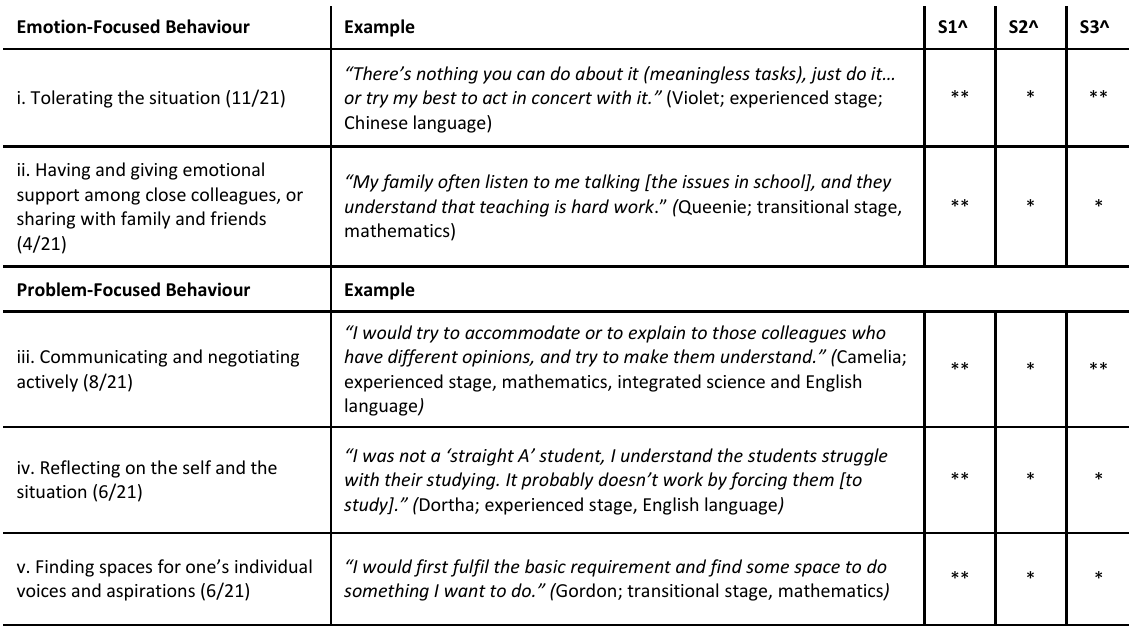
Table 3. Findings on coping